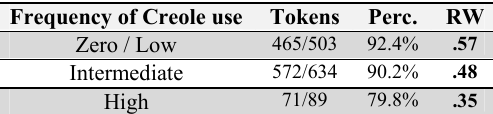
Table XIV: Third person plural marking and Frequency of Creole use in PST (all informants)